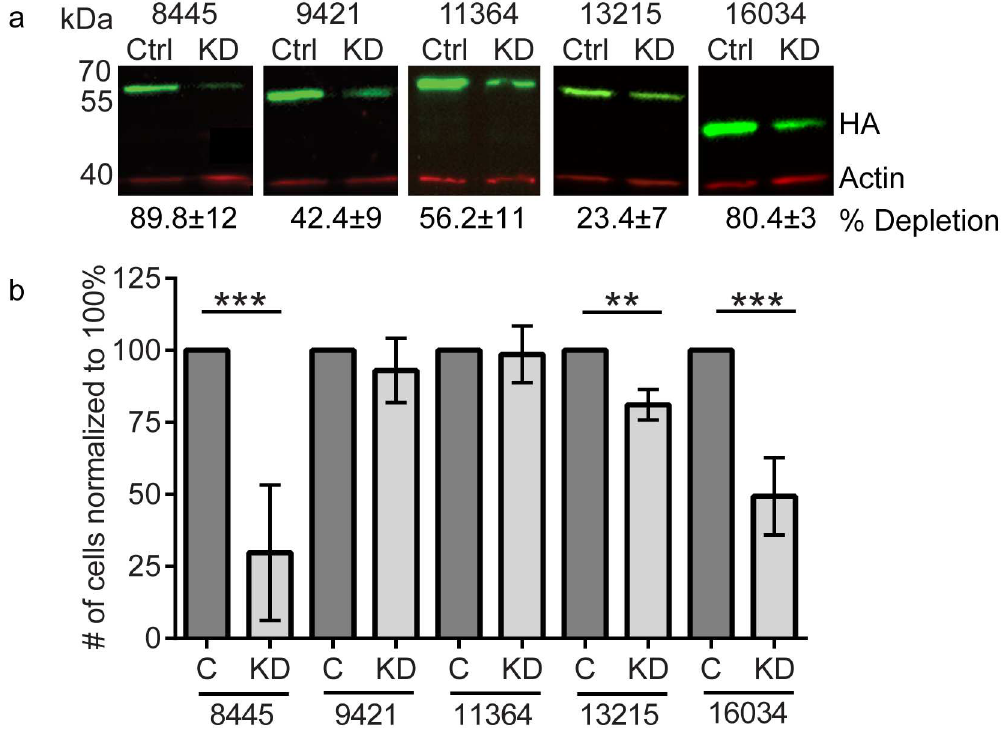
Fig 5. Kinase depletion interferes with growth. The five tagged-kinases shown to express in trophozoites were knocked down using anti-sense morpholinos. (a) Knockdown was measuredand quantifiedby Western blot analysis, HA (green) and actin as loadingcontrol (red) (b) Cell growth was assessed after morpholinoknockdown. Experiments were replicateda minimum of three times and significance was evaluatedby t-test, * = p < 0.05, ** = p < 0.01, *** = p <